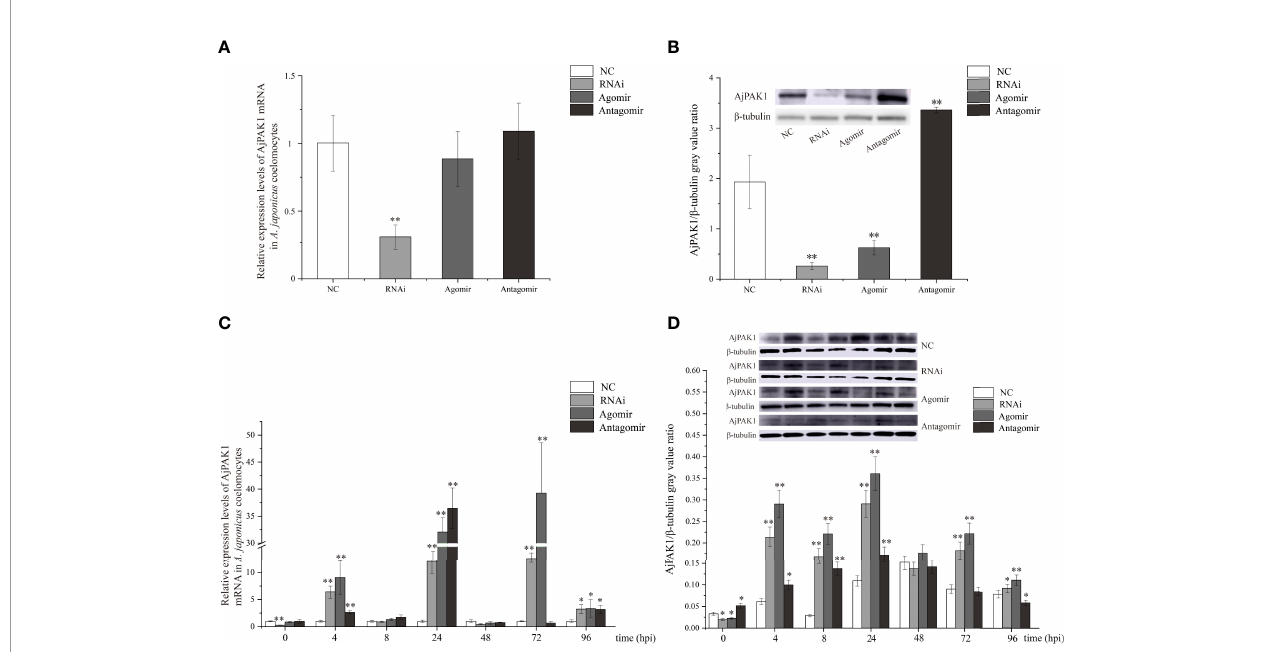
FIGURE 3 | Relative expression of AjPAK1 in coelomocytes of Apostichopus japonicus . (A) Relative expression levels of AjPAK1 mRNA in A. japonicus coelomocytes after AjPAK1 silencing, miR-7 overexpression, or miR-7 inhibition. (B) Expression levels of AjPAK1 protein in A. japonicus coelomocytes after AjPAK1 silencing, miR-7 overexpression, or miR-7 inhibition. (C) Relative expression levels of AjPAK1 mRNA in A. japonicus coelomocytes after AjPAK1 silencing, miR-7 overexpression, or miR-7 inhibition upon Vibrio splendidus infection. (D) Expression levels of AjPAK1 protein in A. japonicus coelomocytes after AjPAK1 silencing, miR-7 overexpression, or miR-7 inhibition upon V. splendidus infection. NC, negative control; RNAi, AjPAK1 silencing; Agomir, miR-7 overexpressed; Antagomir, miR-7 inhibition. ** represents an extremely signi fi cant difference compared with NC or 0 hpi ( P < 0.01); * represents signi fi cant difference compared with NC or 0 hpi ( P <